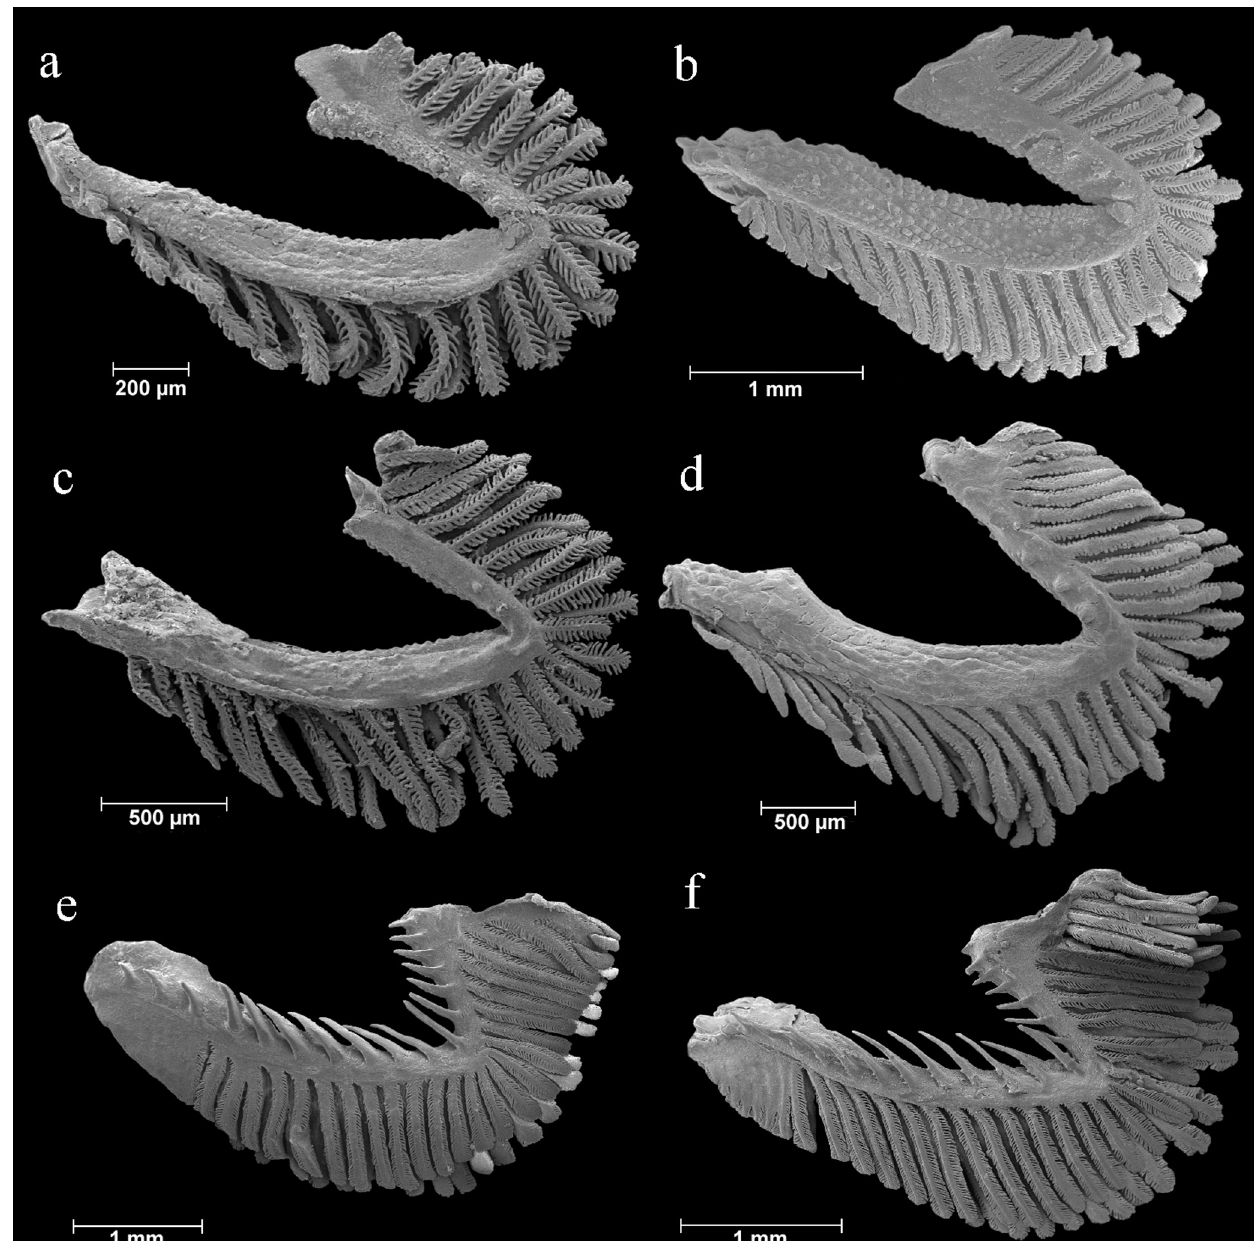
Fig. 6a-f. First branchial arches, left side, external view: (a) Amazonspinther dalmata , MCP 37571, female 14.05 mm SL, (b) Spintherobolus papilliferus , MZUSP 51022, unsexed 23,79 mm SL, (c) Spintherobolus broccae , MCP 19196, unsexed 17.43 mm SL, and (d) Spintherobolus ankoseion , MCP 19280, female 23.10 mm SL. Below cheirodontines: (e) Cheirodon ibicuhiensis , MCP 13663, male 36.10 mm SL, and (f) Serrapinnus heterodon , MZUSP 16740, male 30.20 mm Color in life. Body translucent, allowing view of glass blad- on base of 1 st branched pectoral fins and 1 st unbranched pelvic der and vertebral column (Fig. 7). A greenish metallic yellow fin ray in a few specimens. Adipose fin hyaline. Caudal fin iridescent line along vertebral column more evident depending with few scattered black chromatophores on upper and lower on angle of light incidence. Proximal portion of pleural ribs lobes, clearer area just behind caudal blotch. and opercle iridescent (Fig. 7). Snout with scarce black chromatophores; few chromato- phores on upper lip. Epidermis covering fontanels well- pigmented; epidermis covering frontals and parietals, with deep-lying black chromatophores over brain underneath to frontals and parietals.